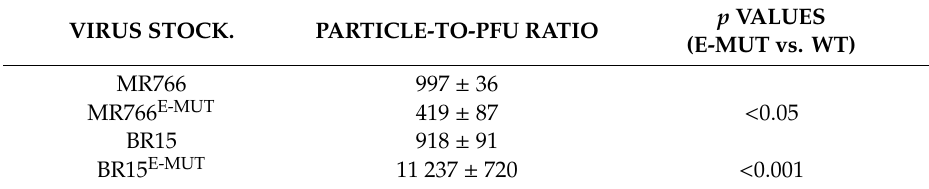
Table 1. Table showing particle-to-PFU ratios. Viral RNA extracted from viral stock P2 were subjected to quantification by RT-qPCR using E primers. Obtained Ct values were plotted in a standard curve (serial dilutions of plasmid copies) in order to get the number of viral RNA molecules per mL. These results were compared to viral stock quantifications by standard plaque-forming assay, which then gave the particle-to-PFU ratios, also named vRNA-to-PFU ratios. Values represent means and standard errors of two to four independent experiments. p VALUES VIRUS STOCK. PARTICLE-TO-PFU RATIO (E-MUT vs. WT) MR766 997 ± 36 MR766 E-MUT 419 ± 87 < 0.05 BR15 918 ± 91 BR15 E-MUT 11 237 ± 720 <